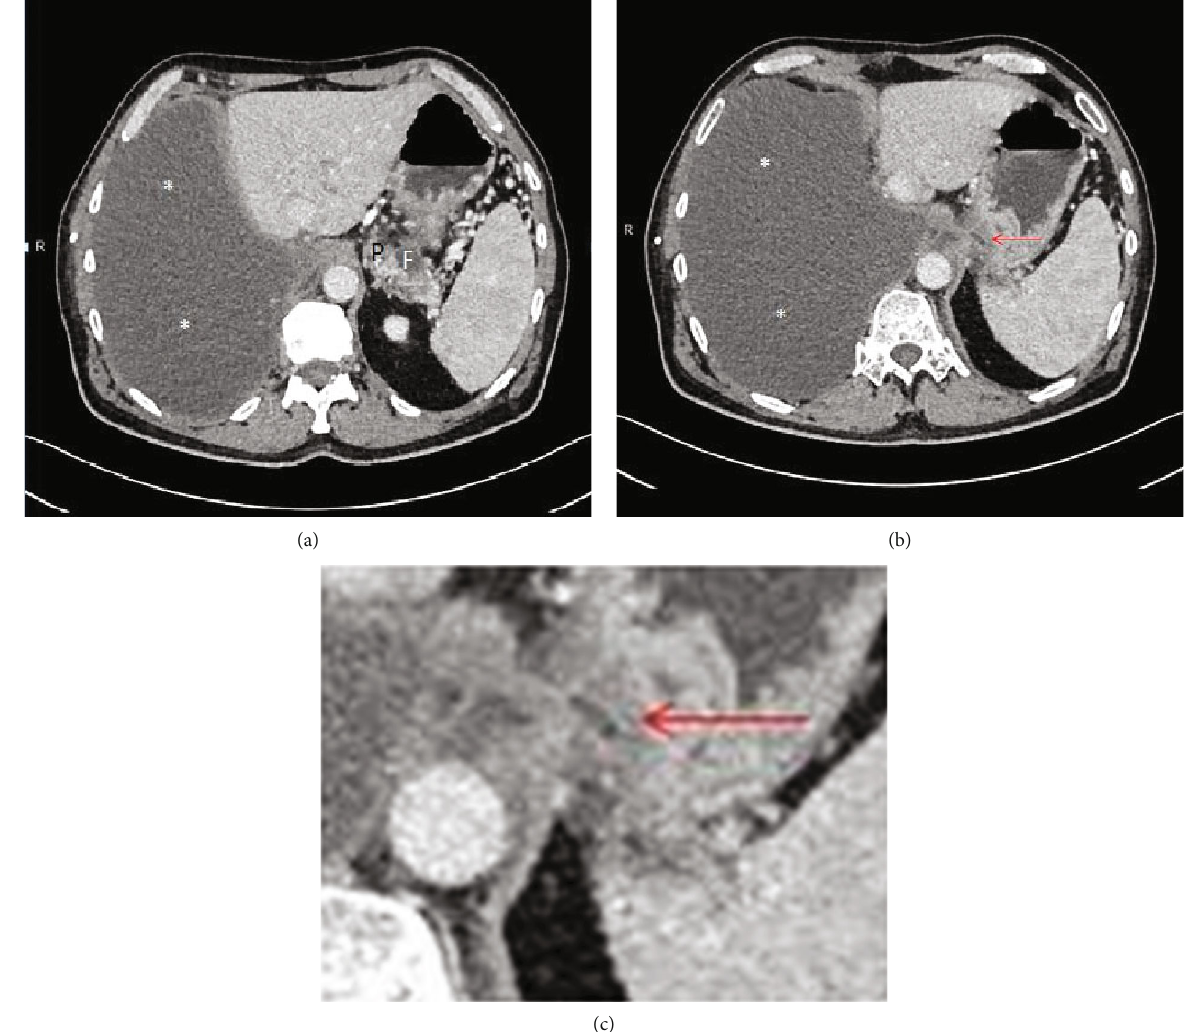
Figure 4: Computed tomography of the abdomen after intravenous contrast injection in axial plane. Enhancement of fi stulous track walls that connect peripancreatic fl uid collection with right pleural cavity (a, b). Fistula is better seen after enlargement (c). P: pancreas; F: fl uid collection. ∗ Free fl uid in pleural cavity. Red arrow: fi